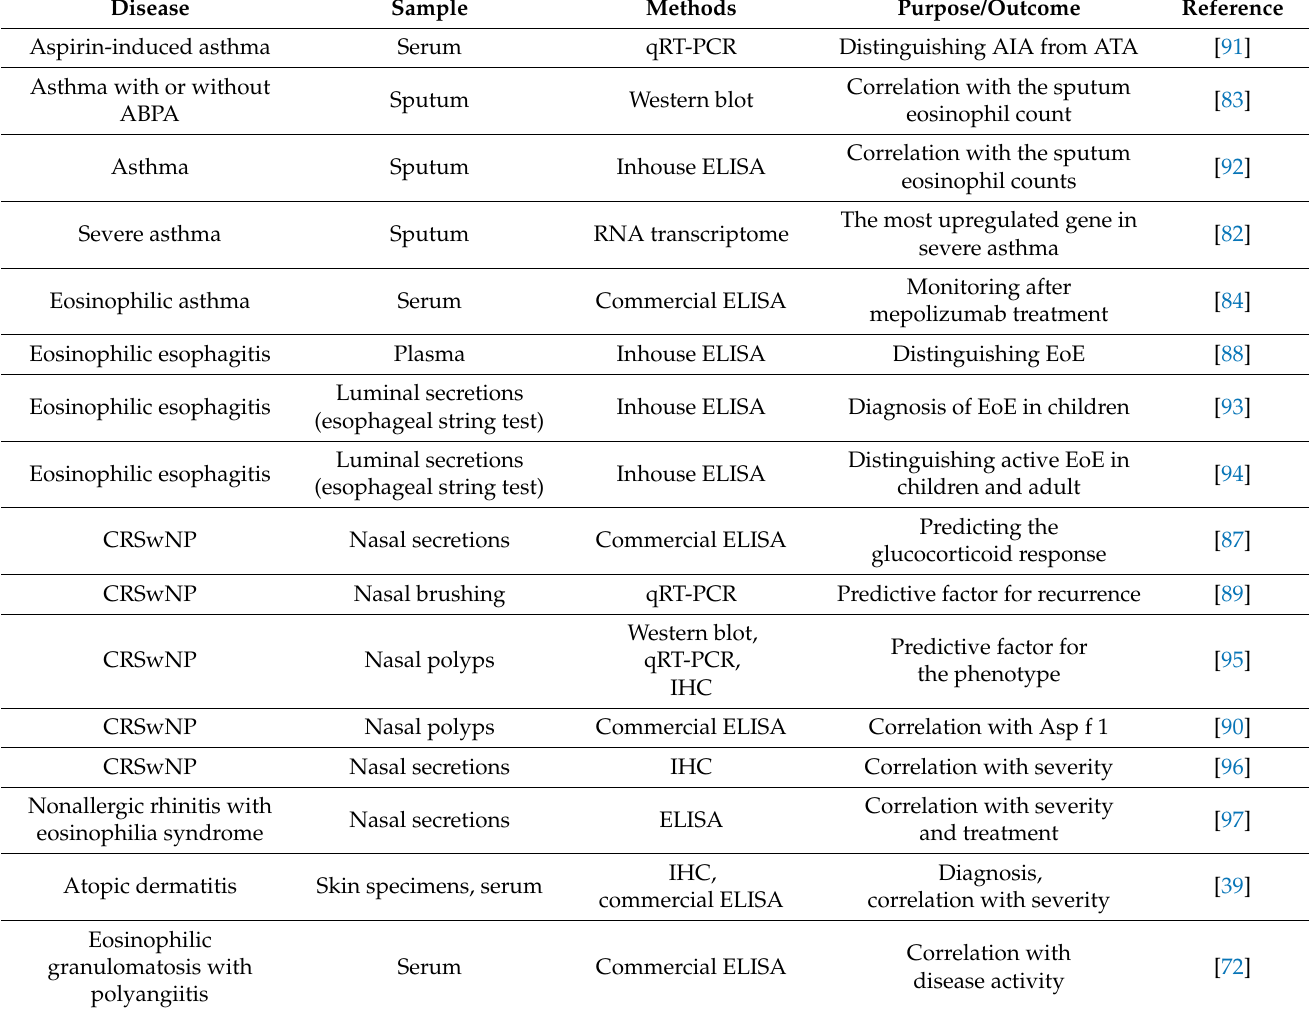
Table 1. Galectin-10 as a biomarker in human